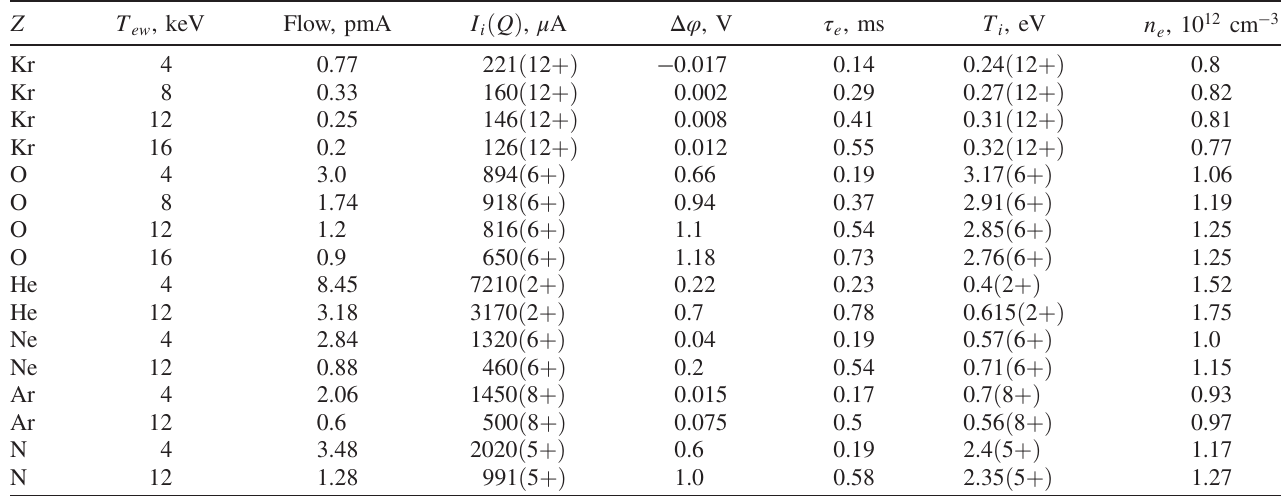
TABLE II. Main parameters of the plasma with injecting one working gas (krypton, oxygen, helium, neon, argon, and nitrogen). The coupled microwave power is 500 W.